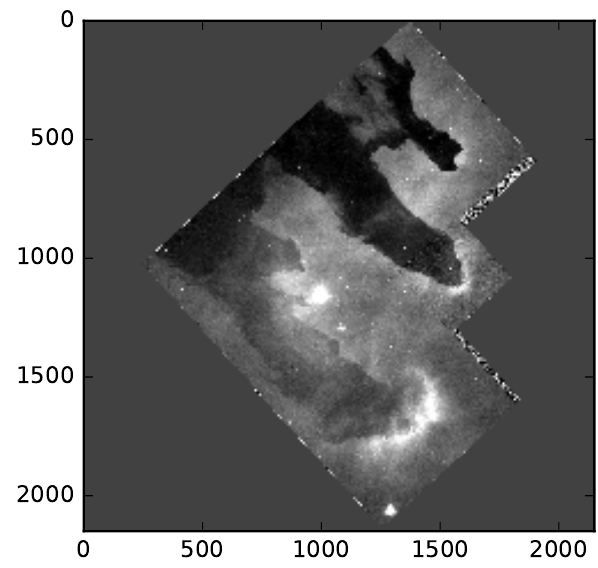
Fig. 97.— This is not the image of a black hole